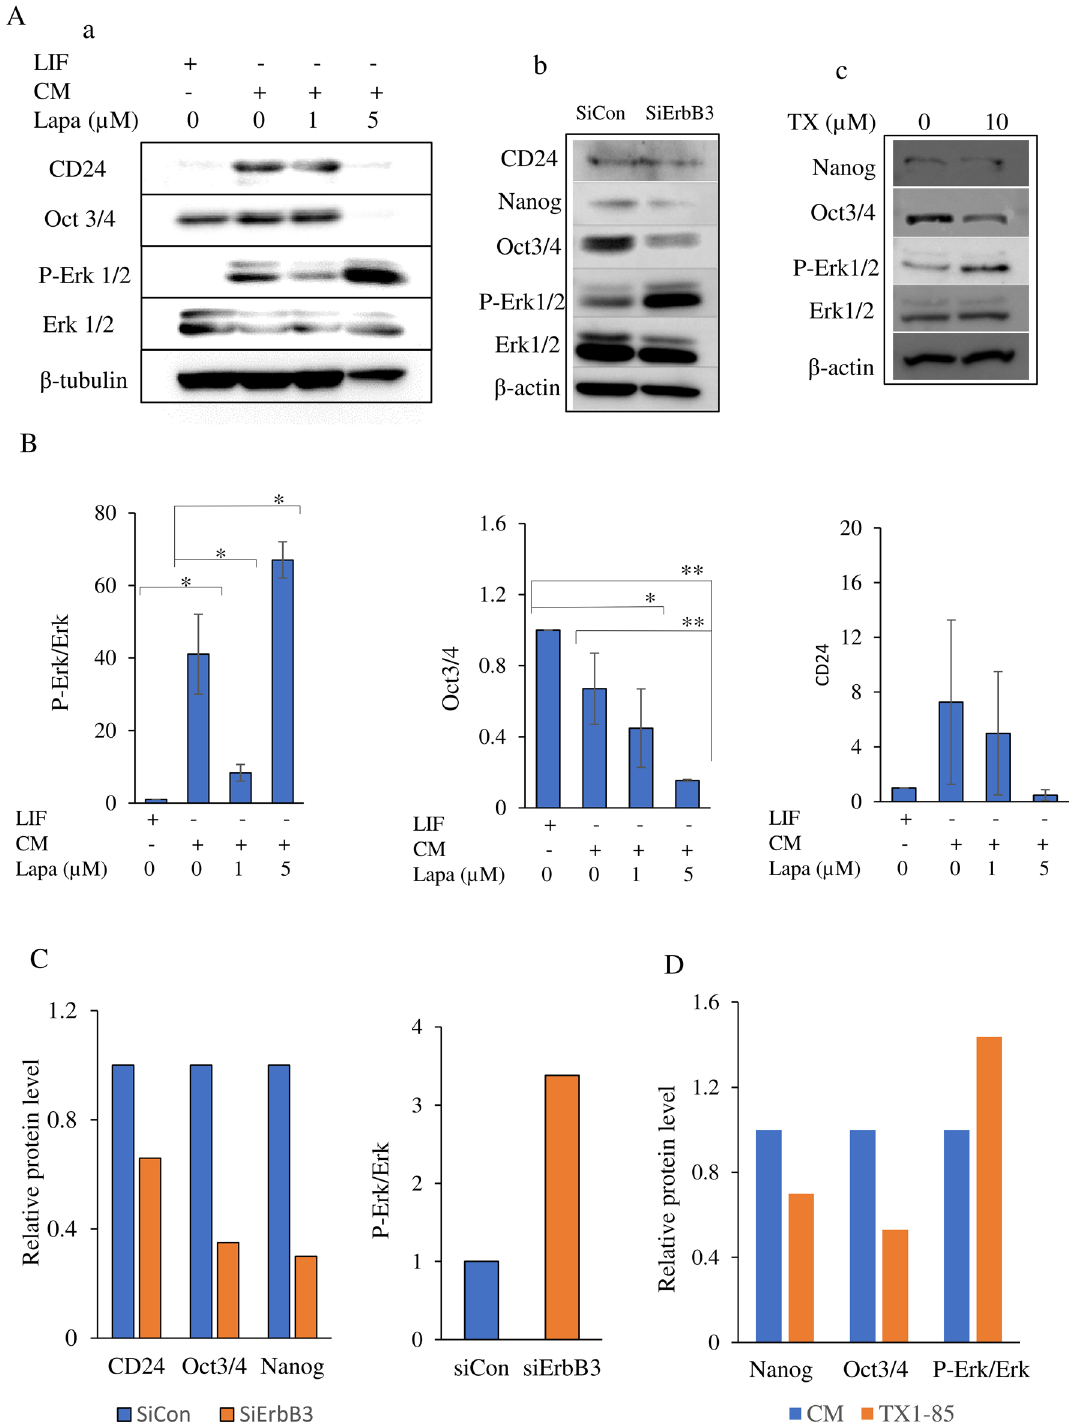
Figure 6. Inhibition of ErbB2 or ErbB3 modulated Erk activation and decreased stemness. ( A ) Western blot analysis of miPSCs cultured in different conditions, in the presence of lapatinib ( a ), by inhibition of ErbB3 with siRNA ( b ) or in the presence of TX1-85-1 ( c ). Antibodies against β-tubulin, β-actin, Erk1/2, phospho-Erk1/2, Oct3/4, Nanog and CD24 were used as primary antibodies. ( B–D) Bar graphs represent relative protein levels normalized with β-tubulin or β-actin levels in the presence of lapatinib ( B ), by inhibition of ErbB3 with siRNA ( C ) or in the presence of TX1-85-1 ( D ). siCon: Negative siRNA control, siErbB3: ErbB3 siRNA. Results in ( Aa )) are representative of three experiments and values in B are mean ± SE. *, p < 0.05; **, p <